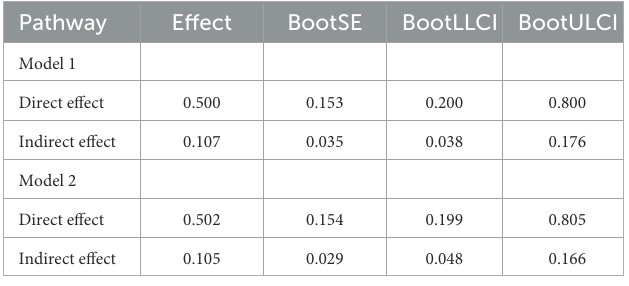
TABLE 4 Table of direct effect, indirect effect, and mediation effect.